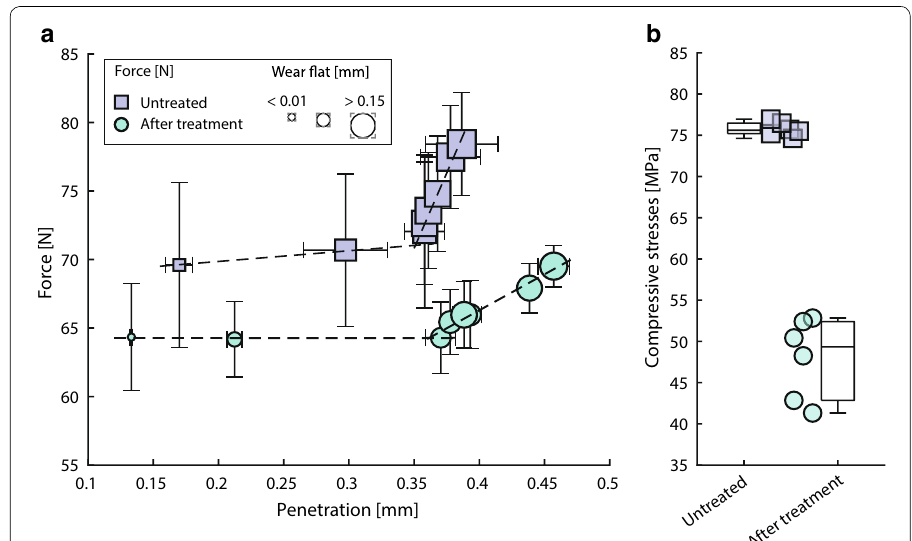
Fig. 6 Cutting forces in sandstone. The cutting forces exerted on the tool during the tests are shown in a as a scatter plot for Rorschach sandstone under untreated (violet squares) and after-treatment (green circles) conditions. Symbol sizes indicate the wear flat measured at the tool tip (see legend). Here, the curves obtained from bi-linear regressions of the data are shown as dashed lines. In b , the compressive stresses, exerted on the tool by the rock are calculated using the measured force values, the contact surface area under the stress state and a friction coefficient of 0.65 (Roshan et al. 2017). In b , the scattered data distributions, representing the strength of the rock, are summarized by boxes, where the central mark indicates the median value, the bottom and top edges of the box the 25th and 75th percentiles, respectively, and the error bars represent the standard deviation